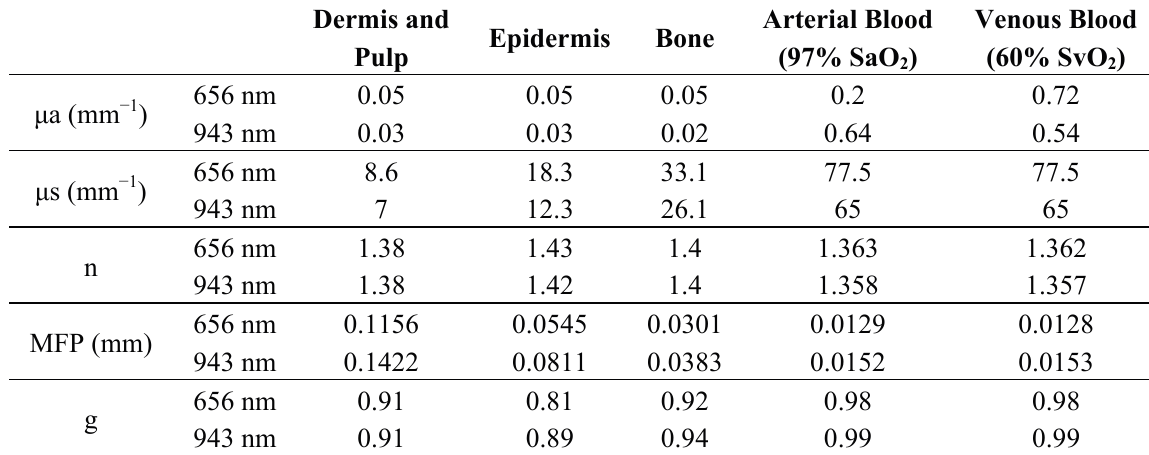
Table 1. Optical properties of tissues in simulation.